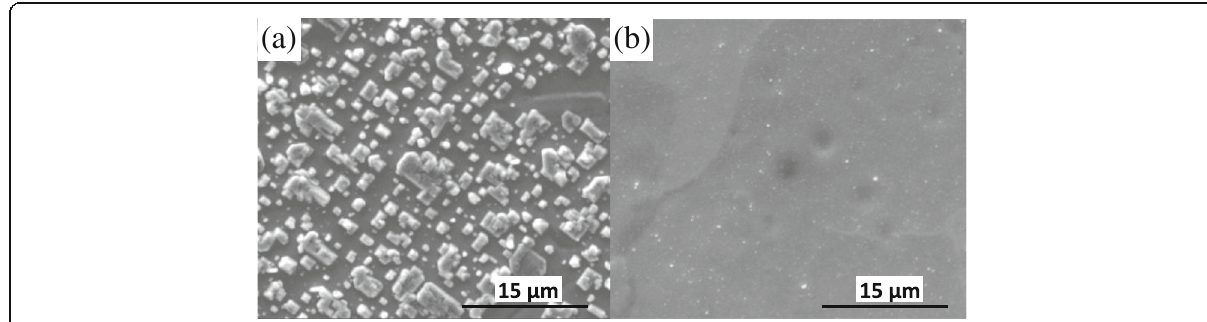
Fig. 1 SEM images of STO films deposited at 700 °C with laser frequency and chamber pressure of a 2 Hz and 10 − 3 mbar and b 10 Hz and 10 − 4 mbar, respectively